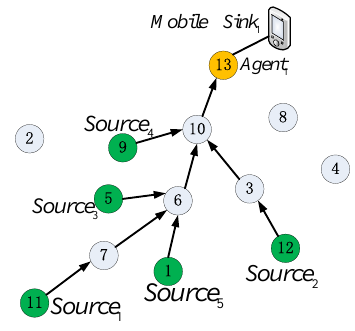
Figure 5. Multi routing paths share some relay nodes.